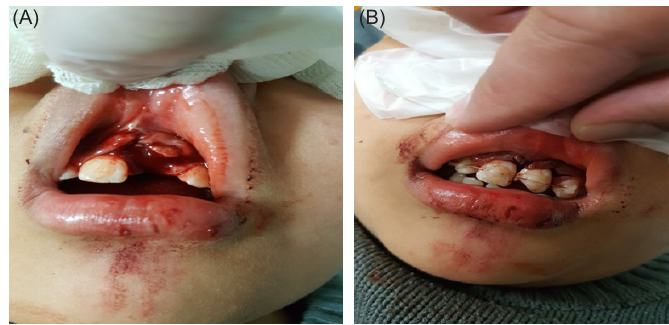
Figure 1. (A) Dental injury in 8 years old child. (B) Treatment of